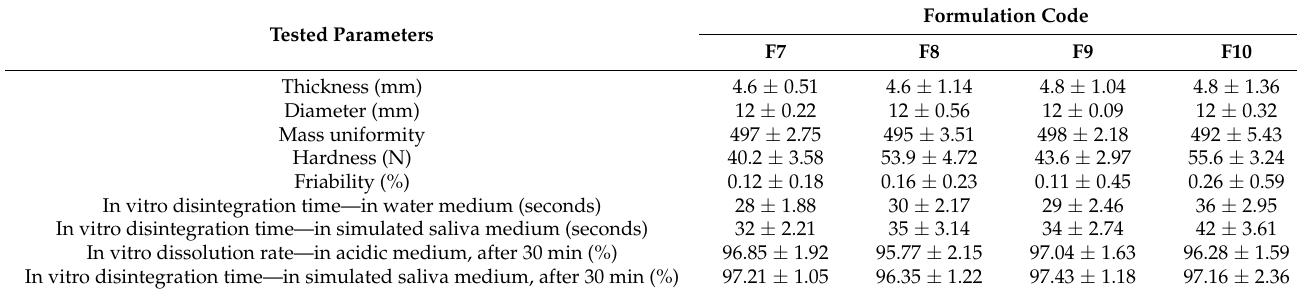
Table 5. Quality properties of the studied tablets. Tested